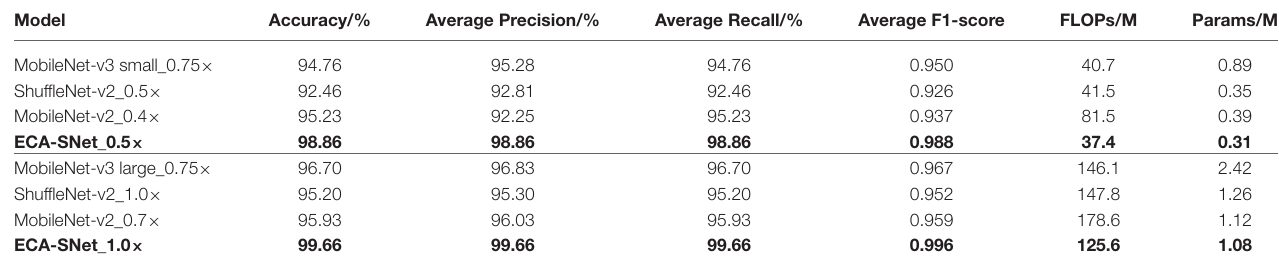
TABLE 4 | Performance comparison of the proposed ECA-SNet against the classical lightweight CNNs.